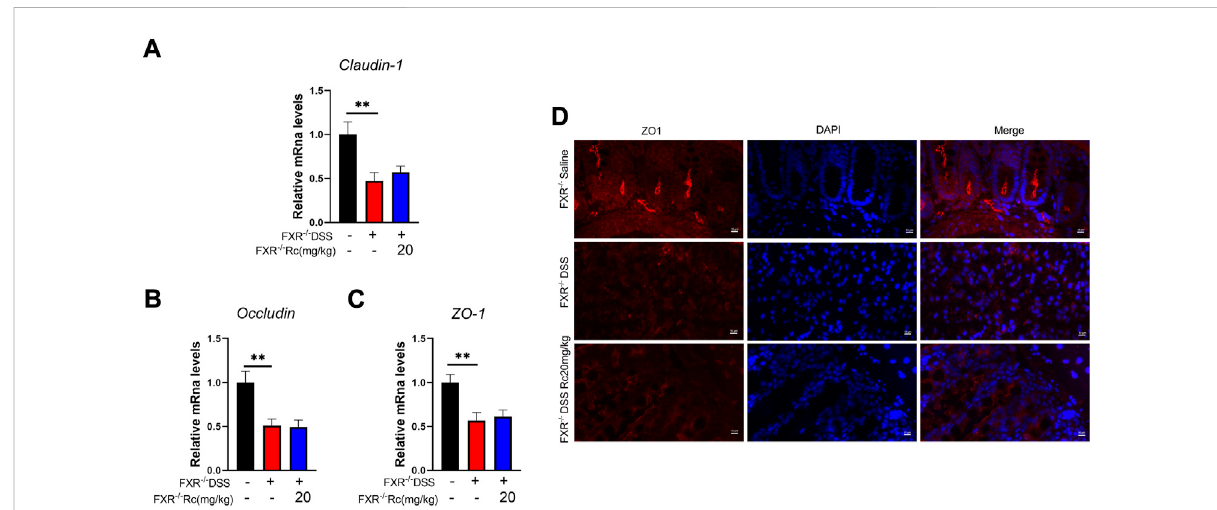
FIGURE 8 The absence of FXR blocked the effect of Rc maintaining tight junctions in DSS-induced FXR − /- mice. The colons were collected for qPCR analysis, and the relative mRNA levels of claudin-1 (A) , occludin (B) , and ZO-1 (C) were measured; representative images of immuno fl uorescence of ZO-1 (D) in mouse colon sections (magni fi cation: 200 ×). Data are shown as the mean ± SEM ( n = 6). ** p < 0.01 vs . the saline